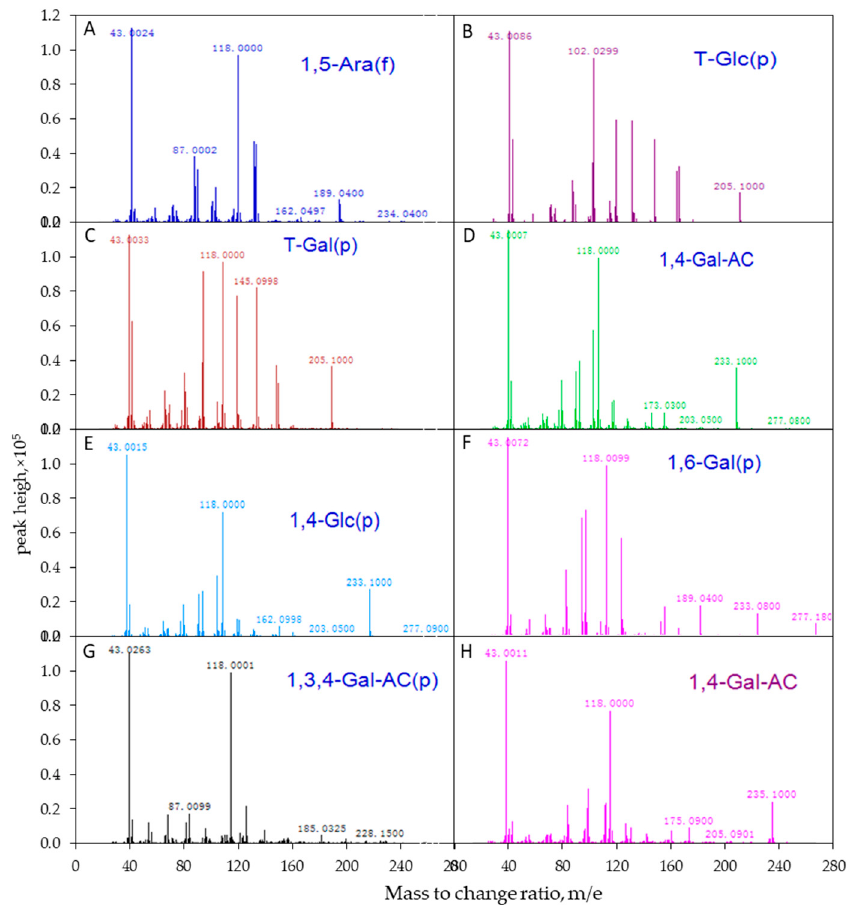
Figure 2. The mass spectrogram of each intrachain residue of APS molecular determined using electron ionization mass spectrometry (EI-MS). The polysaccharide samples were determined by EI-MS after hydrogenation (Figure 2A–G)/treated with deuterium (Figure 2H). (A) (1,5)-furan arabinose residue; (B) terminal glucose residue; (C) terminal galactose residue; (D) (1,4)-galacturonic acid; (E) (1,4)-glucose residue; (F) (1,6)-galactose residue; (G) (1,3,4)-galacturonic acid; (H) (1,4)-galacturonic acid (deuterium generation).